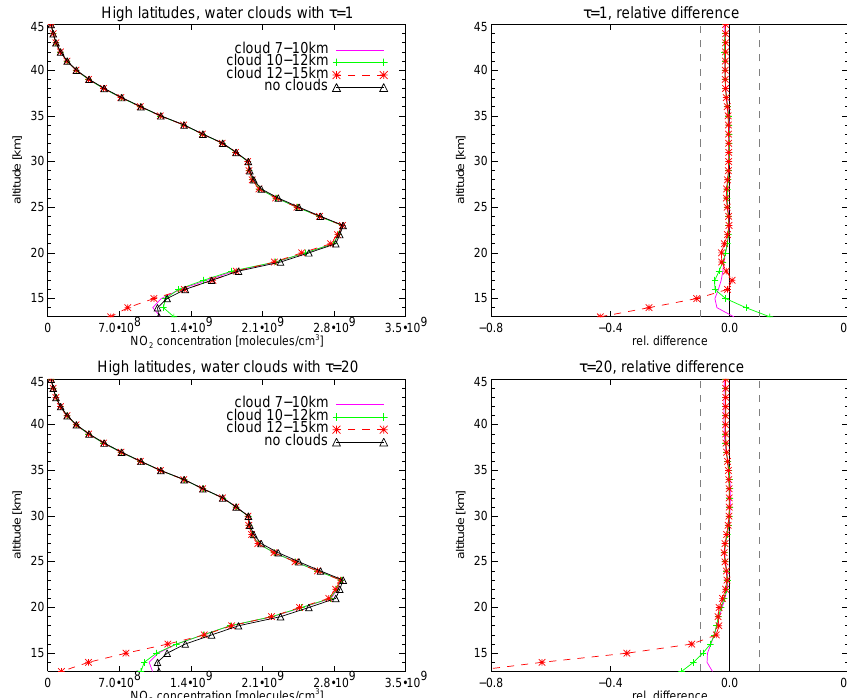
Fig. 6. Same as Fig. 5, but for northern high latitudes (SZA=70 ◦ ), same day.